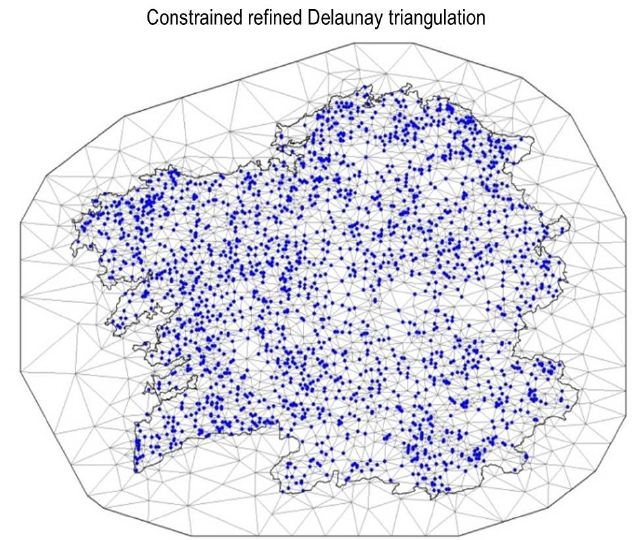
Figure 2. The National Inventory region triangulation with the extended boundary. Blue dots are the monitoring stations and the black bold line represents the region border.